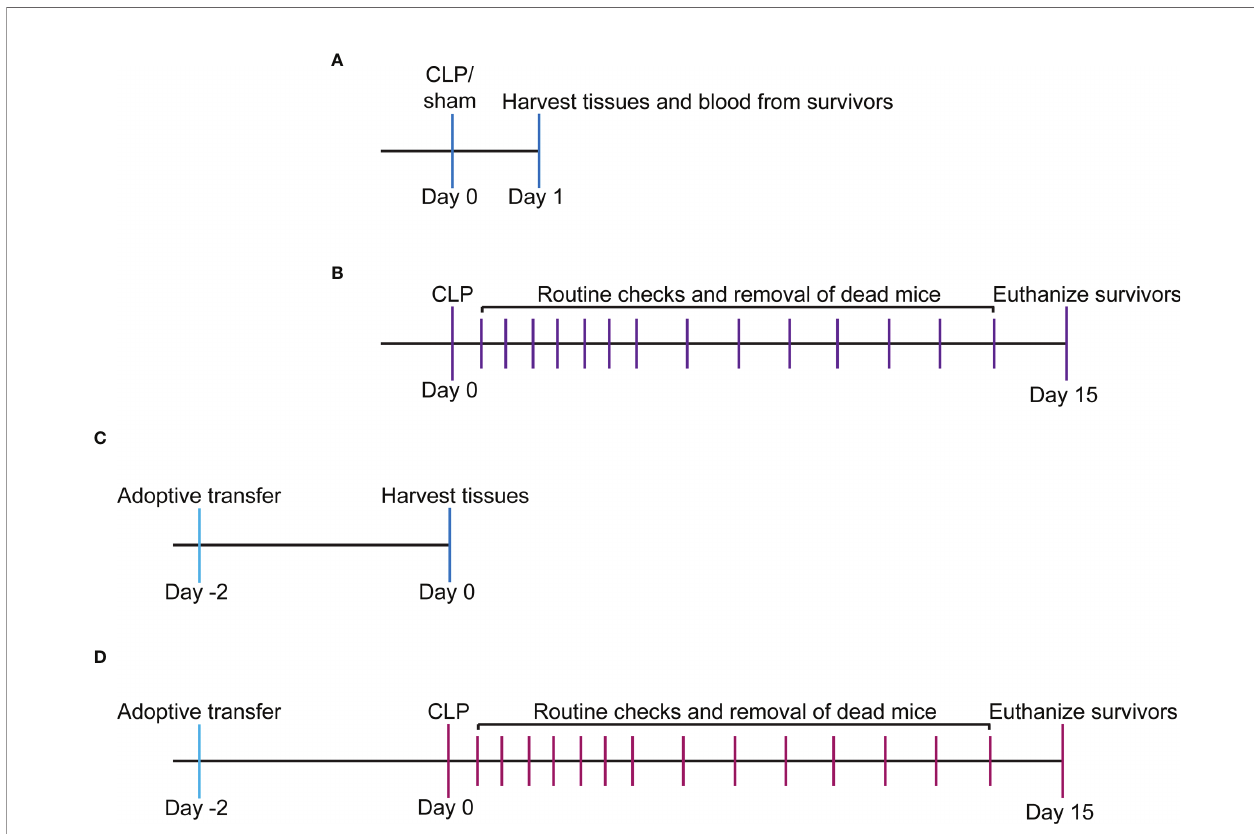
FIGURE 1 | Experimental timeline for study. (A) WT and VISTA -/- mice underwent sham or CLP procedure, and tissues/blood were harvested for downstream analysis via fl ow cytometry or spectrophotometry. (B) WT and VISTA -/- mice underwent a CLP procedure, and survival was tallied for 14 days. Surviving mice were euthanized on the 15th day. (C) WT mice were injected with Jurkat T regs , and tissues were harvested 2 days postinjection for downstream analysis and validation of adoptive transfer via fl ow cytometry. (D) VISTA -/- mice were injected with Jurkat T regs then underwent CLP 2 days postinjection, and survival was tallied for 14 days. Surviving mice were euthanized on the 15th